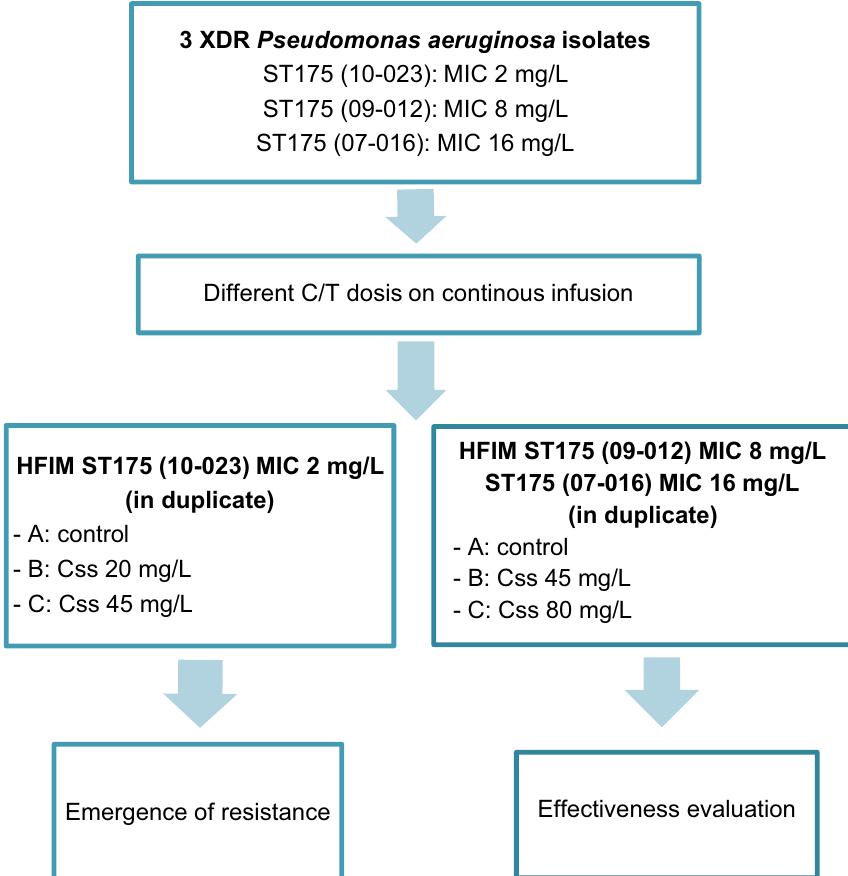
Figure 1. Study flow showing in vitro 10-day HFIM assays conducted with three XDR Pseudomonas aeruginosa ST175 isolates with C/T MICs ranging from 2 to 16 mg/L using different Css of C/T in CI: 20 and 45 mg/L to test the emergence of C/T resistance in the susceptible ST175 (10-023) isolate, and 45 and 80 mg/L to test the effectiveness of C/T against the non-susceptible isolates ST175 (09-012) and ST175 (07-016). C/T, ceftolozane/ tazobactam; HFIM, hollow-fiber infection model; MIC, minimum inhibitory concentration; XDR, extensively- drug resistant; Css, steady-state concentration; CI, continuous